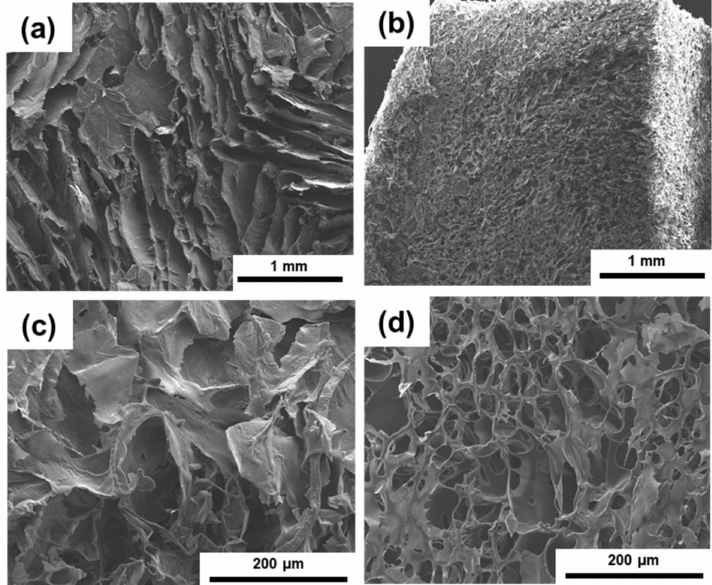
Figure 5. Cross-sectional SEM images of the aerogels after the thermal imidization process. ( a , c ) The PI/CNC composite aerogel using 6.5 wt% CNCs. ( b , d ) Pure PI aerogel.